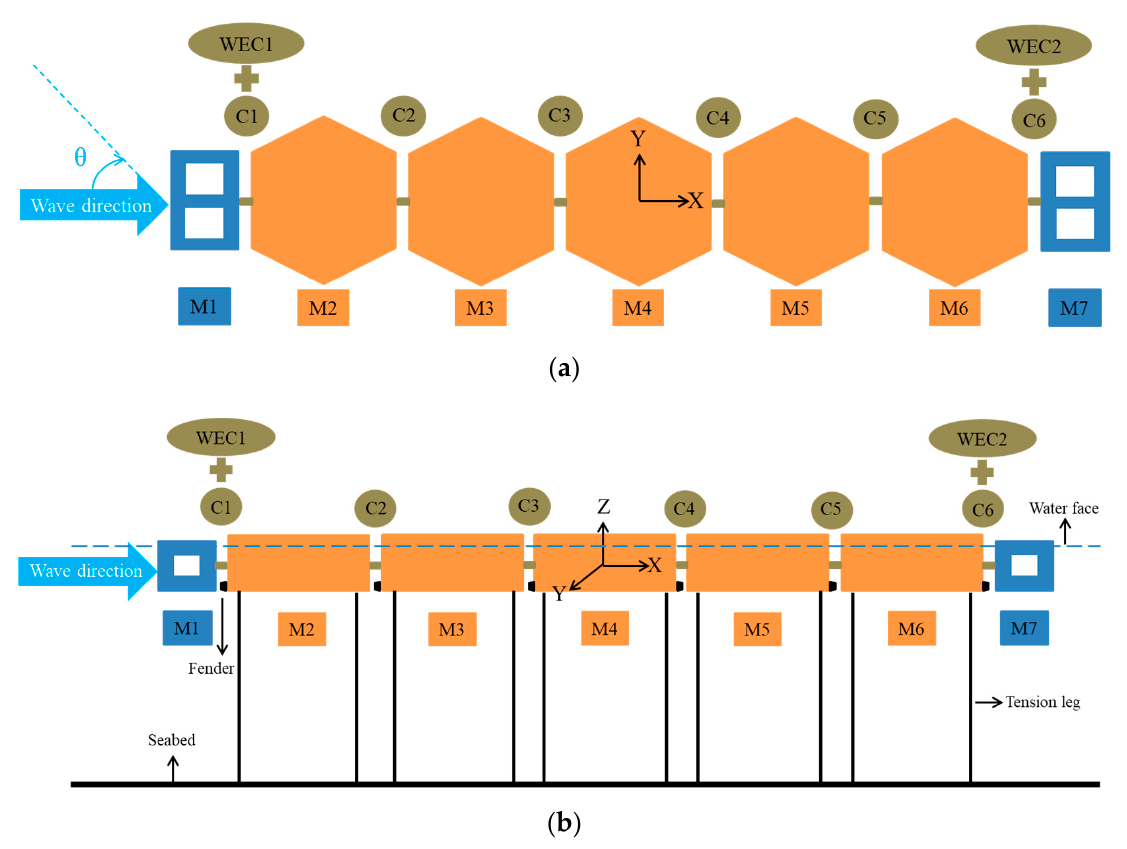
Figure 1. The simplified sketch of the MFS system: ( a ) top view; ( b ) side view. Table 1. Main design parameters of the MFS system. Parameters Value Units Hexagonal floating structure